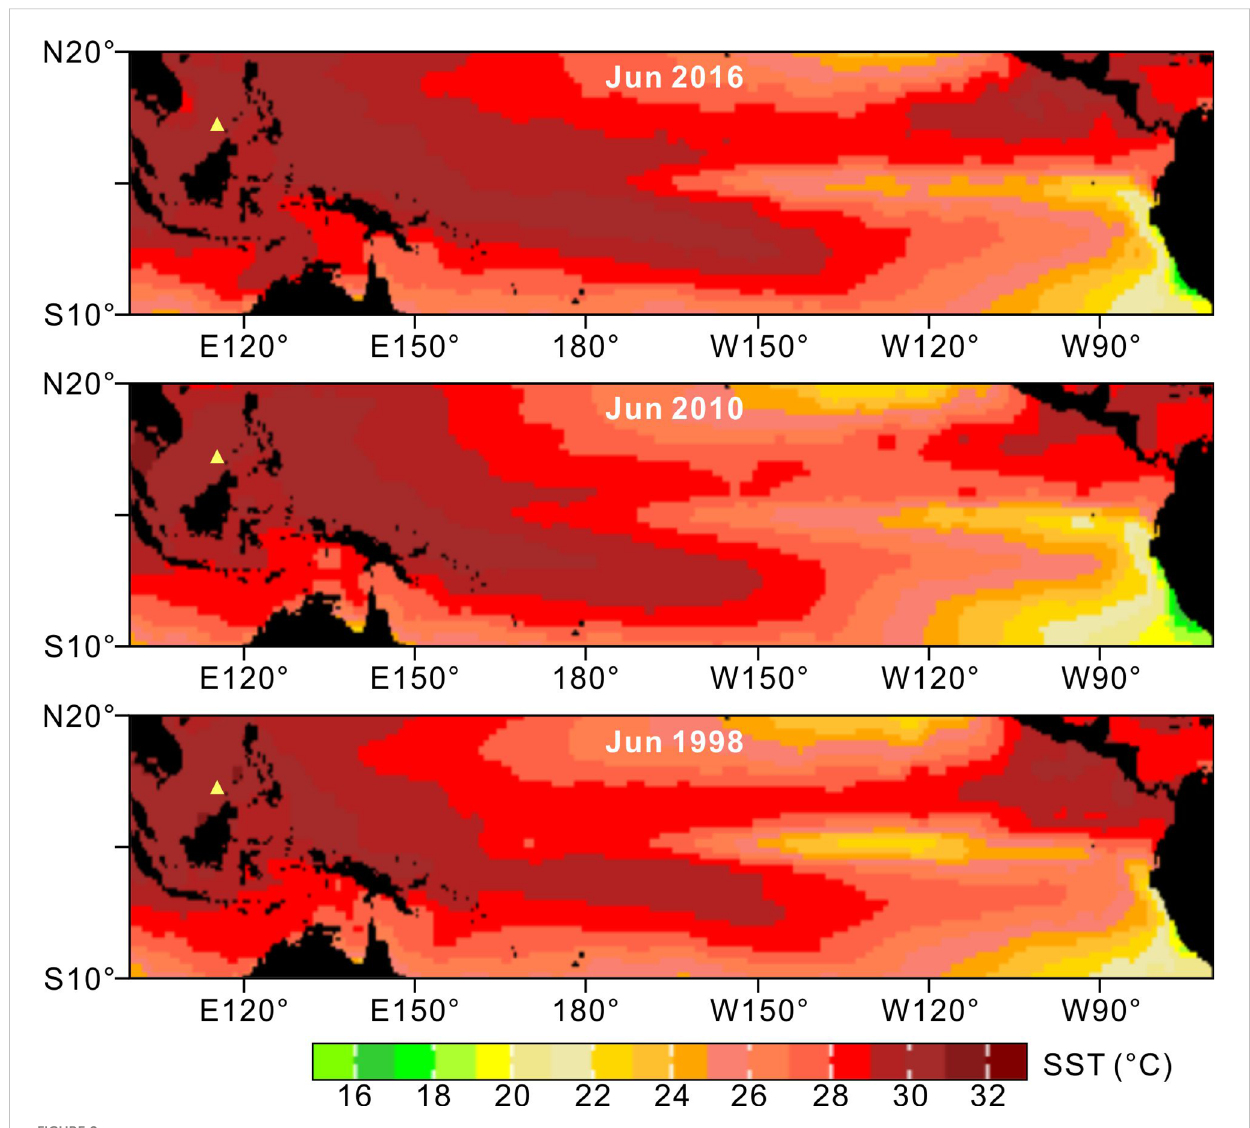
FIGURE 2 Monthly (June) mean sea surface temperatures (IGOSS nmc Reyn_SmithOIv2 monthly SST; Reynolds et al., 2002) displayed the variability of the warm pool structure associated with three strong/extreme El Niño events. Our study site is indicated with a yellow “ D ” in each